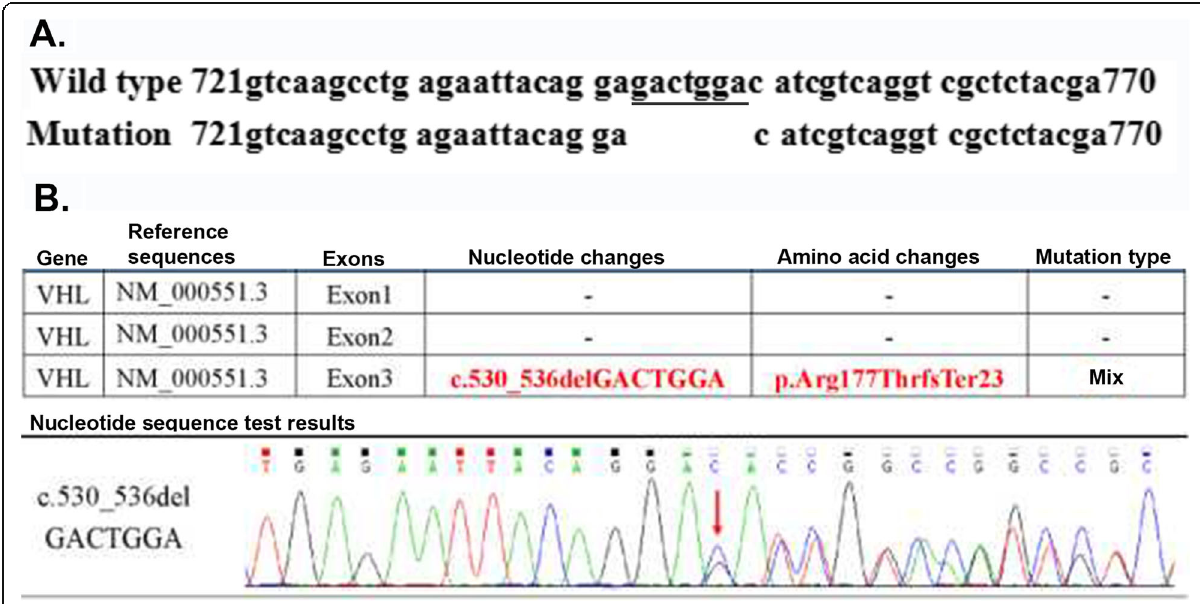
Fig. 4 VHL gene and testing results of case 1. a The top row shows the wild-type human VHL DNA sequence segment of 721 – 770 from the NCBI database (NM_000551.3). The nucleotide database includes EST and GSS sequences. The bottom row shows the deletion of the GACTGGA sequence in the VHL gene of the subject. b Genetic testing results of the patient ’ s VHL gene, indicating the deletion of the GACTGGA sequence, leading to an amino acid Arg-177 change in case 1